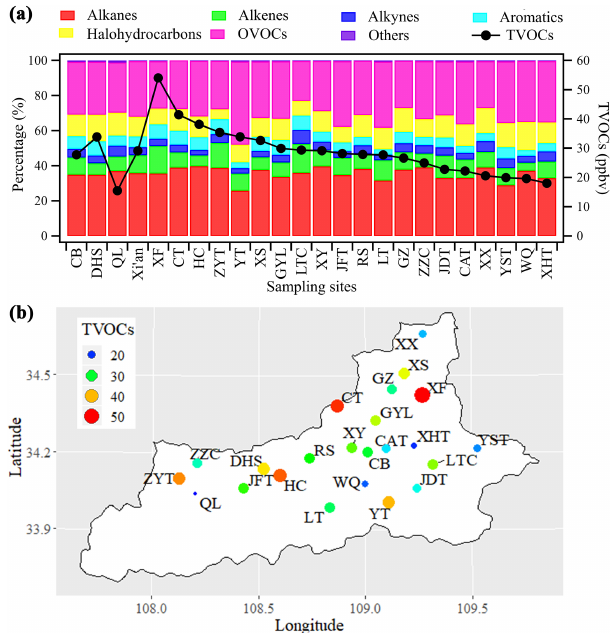
Figure 4. (a) Proportions of seven VOC groups and averaged TVOC concentrations in different sites in Xi’an. (b) Spatial distribution of averaged TVOC concentrations in different sites in Xi’an.